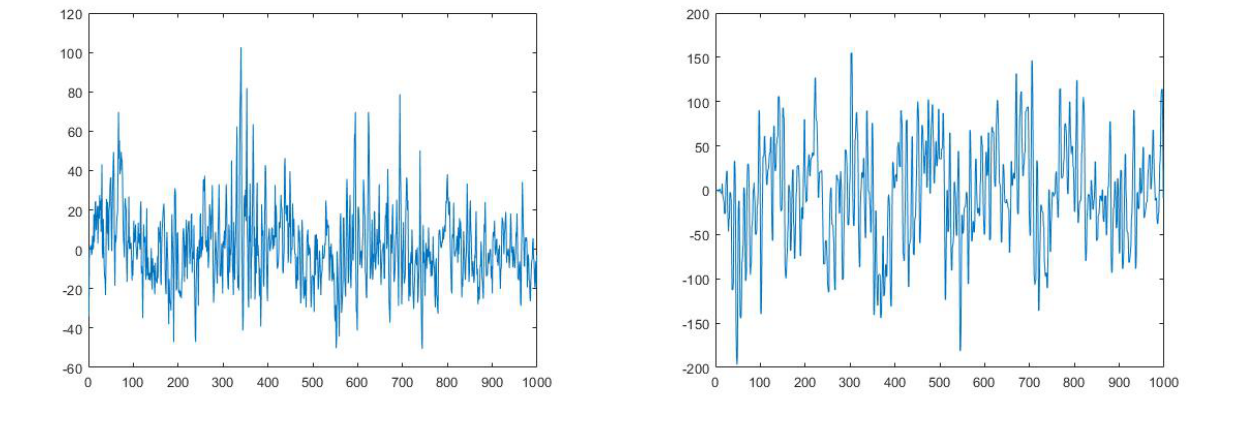
Figure 17. chb05-02 Median Filter